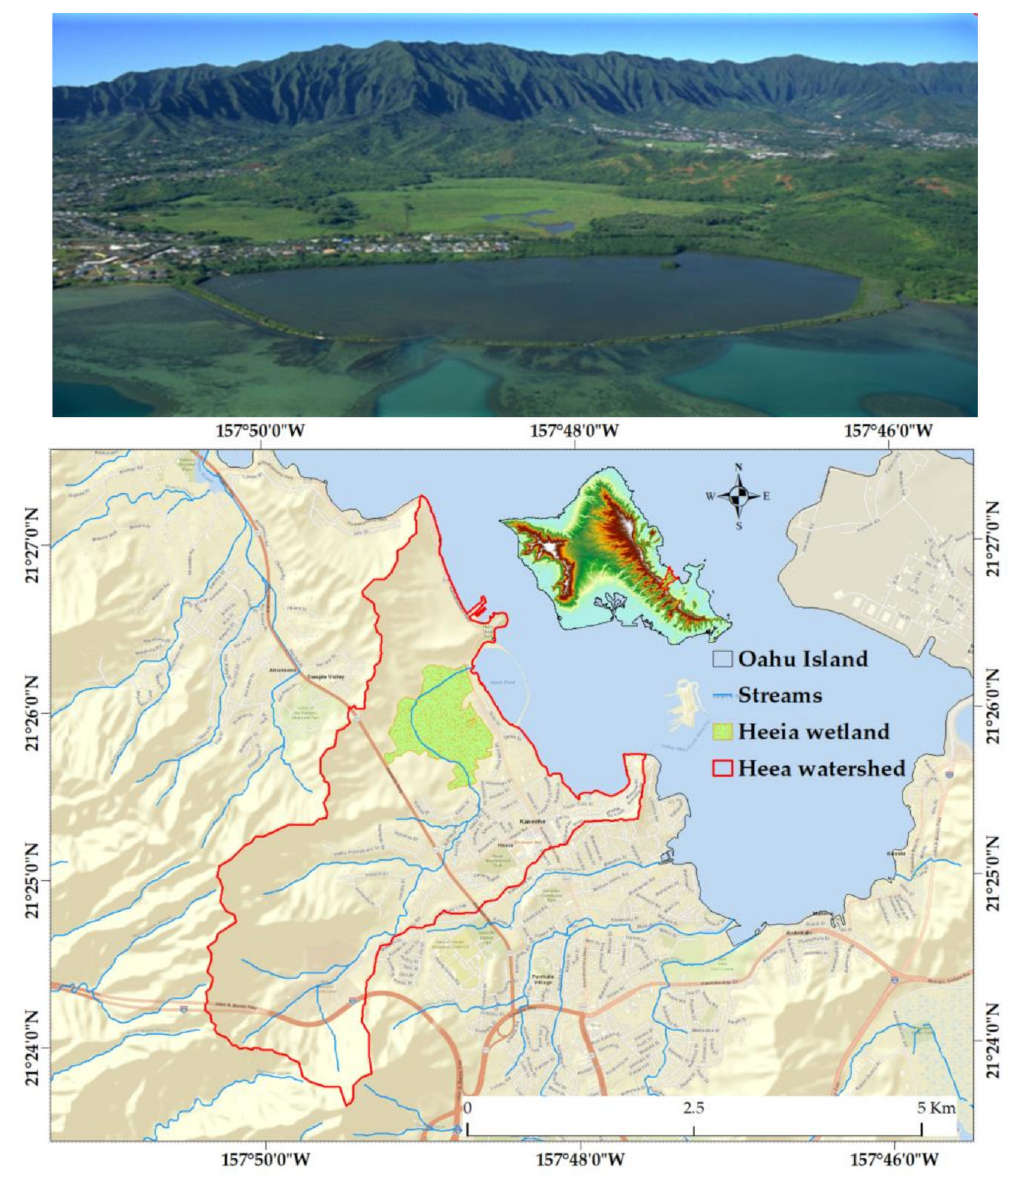
Figure 1. Aerial photo ( top ) and geographic and topographic maps ( bottom ) of the Heeia watershed and downstream